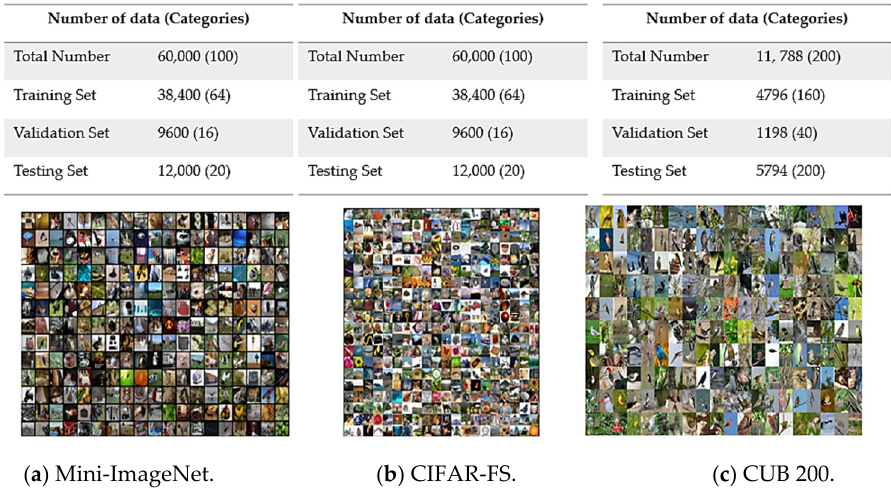
Figure 5. Few-shot classification datasets.